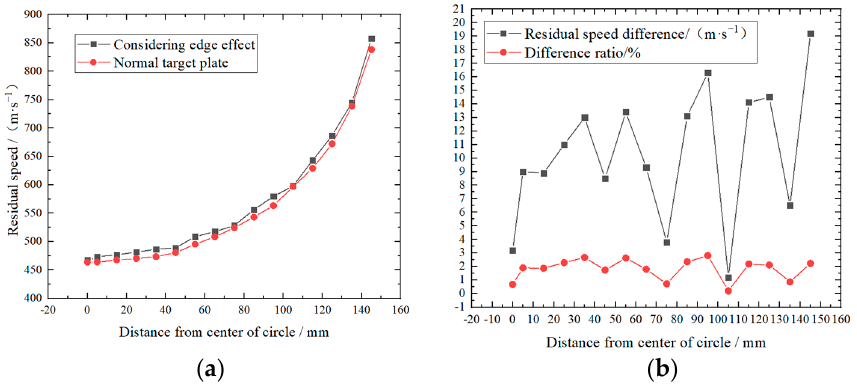
Figure 9. Influence of edge effect on residual velocity. ( a ) is comparison between residual velocity considering edge effect and plane target; ( b ) is residual speed difference and difference ratio under two conditions.